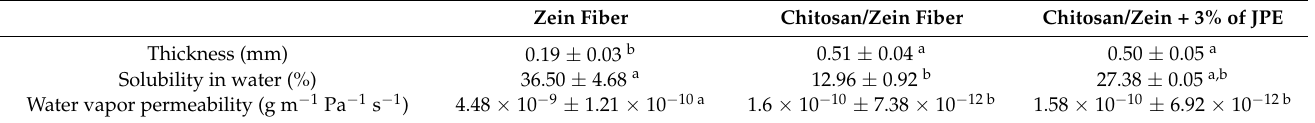
Table 3. Characterization of the zein fiber and bilayer films according to thickness, solubility in water, and water vapor